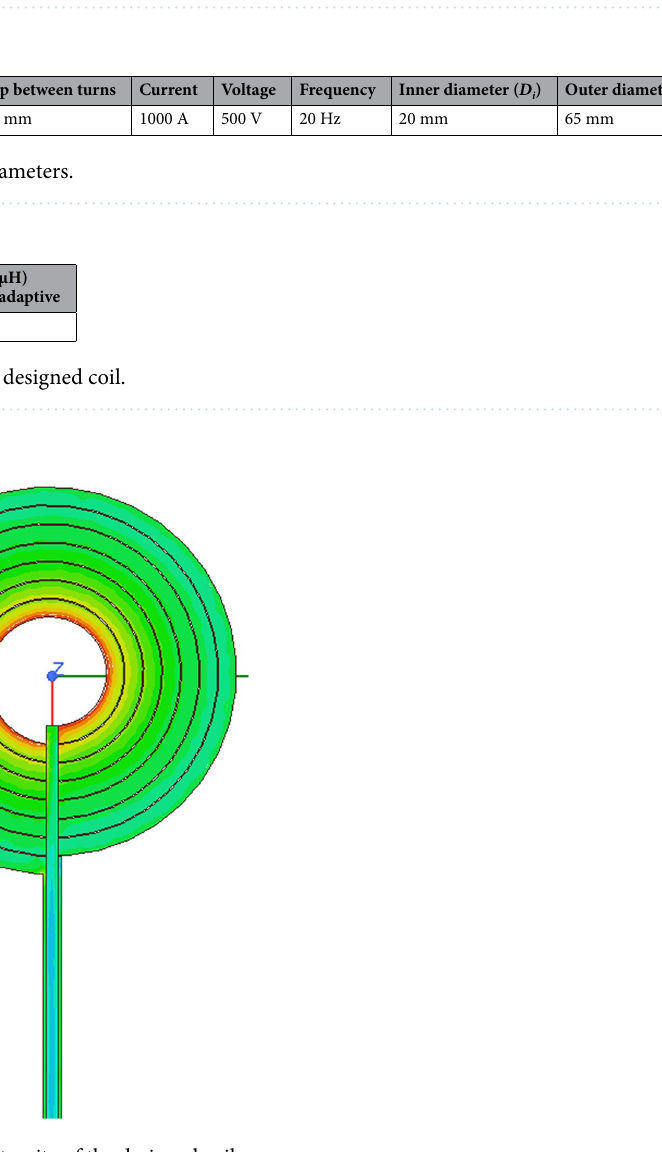
Figure 2. Coil design and parameters.